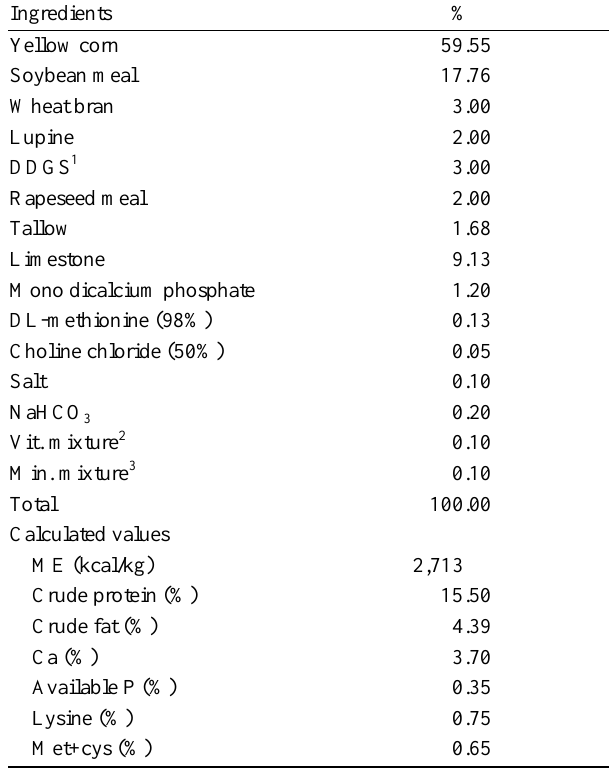
Table 1. Formula and chemical composition of experimental diet